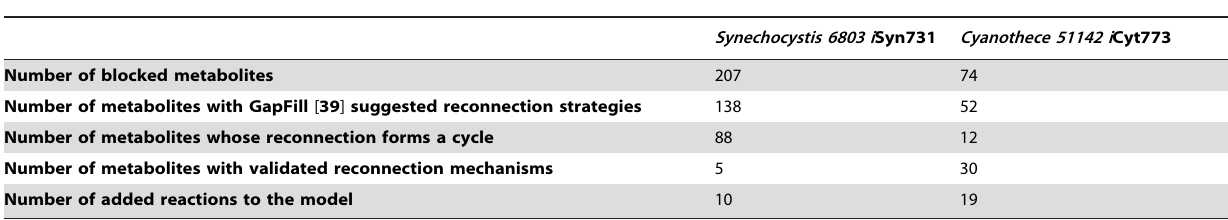
Table 2. Summary of connectivity restoration in Synechocystis 6803 i Syn731 and Cyanothece 51142 i Cyt773